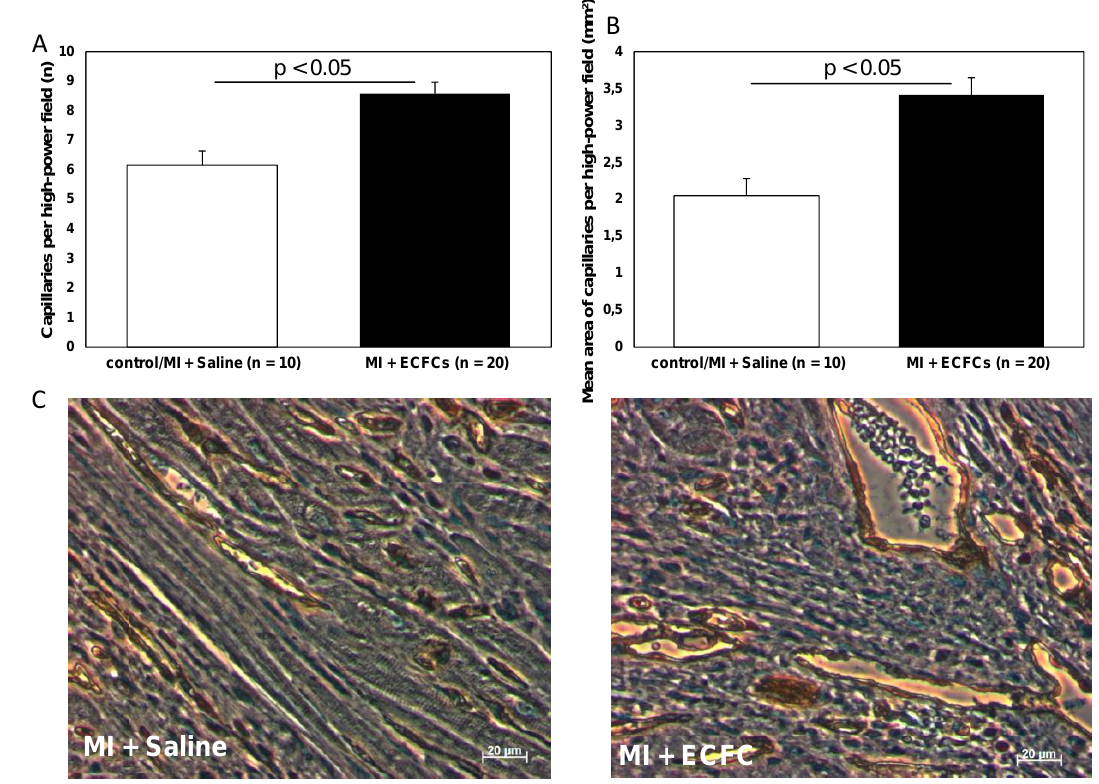
Figure 3. Increased neovascularization after transplantation of human ECFCs into ischemic myocardium. Histograms showing the numbers ( A ) and mean area ( B ) of CD31 + capillaries at the infarct border zone of saline-treated control animals (white bars) and after ECFC transplantation (black bars) 30 days after MI. Data represent mean ± SEM. ( C ) Representative immunohistochemical staining of CD31 (brown) in infarcted hearts 30 days after MI.